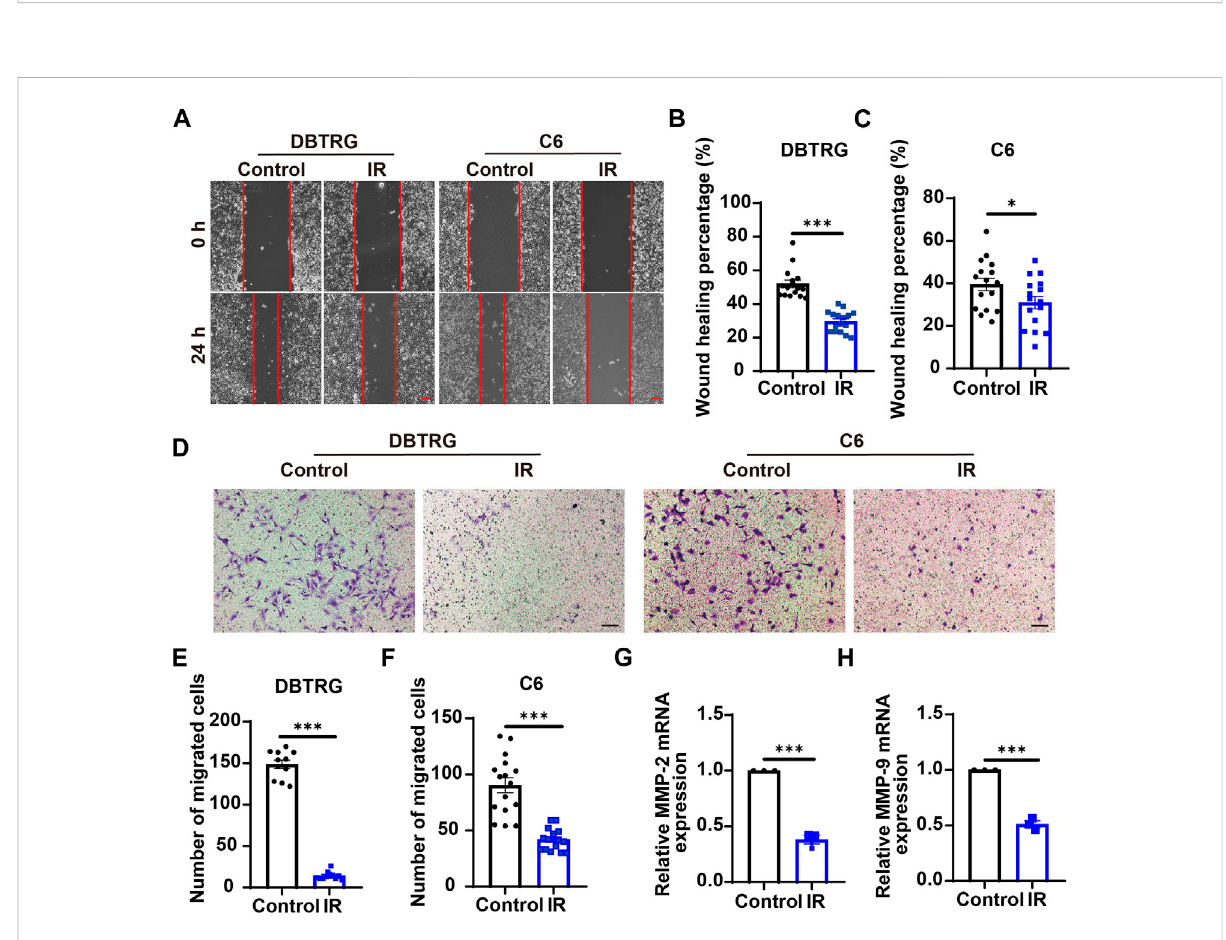
FIGURE 4 IrigeninsuppressedthemigrationofGBMcells. (A) TypicalimagesofDBTRGandC6cellstreatedwith50 μ MIRfor24 hinwoundhealingassay. (B – C) Quanti fi cationofwoundhealingindexinDBTRGcells (B) andC6 cells (C) asshownin (A) ( n =16,pergroup). (D) TypicalimagesofDBTRGand C6 cells treated with 50 μ M IR for 24 h in transwell invasive assay. (E – F) Quanti fi cation of the number of migrated DBTRG (E) ( n = 11, per group) and C6 (F) cells ( n = 16, per group) as shown in (D) . (G – H) qPCR analysis results of MMP-2 mRNA levels (G) and MMP-9 mRNA levels (H) in DBTRG cells treated with or without IR ( n = 3, per group). Scale bars, 100 μ m. Data were shown as mean ± SEM. *p < 0.05, ***p < 0.001, compared with control